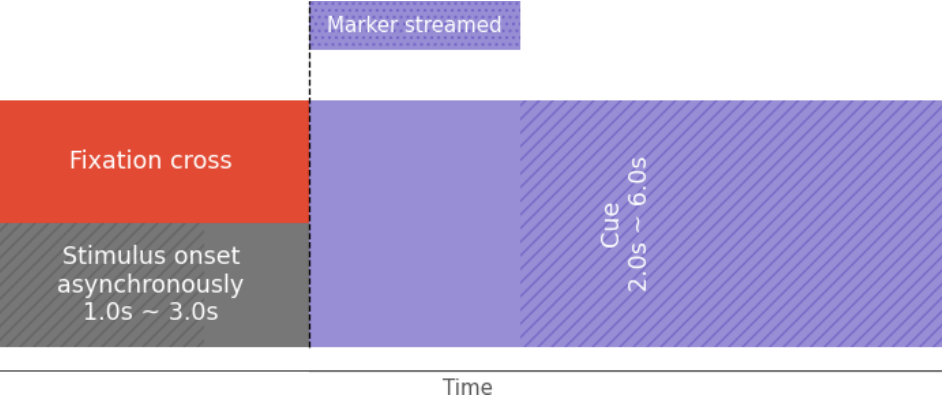
Figure 7. Tested Motor Imagery paradigm holding markers indicators for our OpenBCI-based framework.